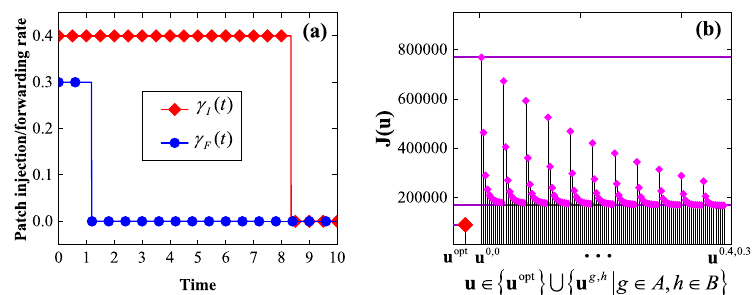
Figure 9. The experimental results in Example 3: ( a ) an optimal control, ( b ) a comparison between the optimal control and the set of static controls in terms of the energy efficiency.